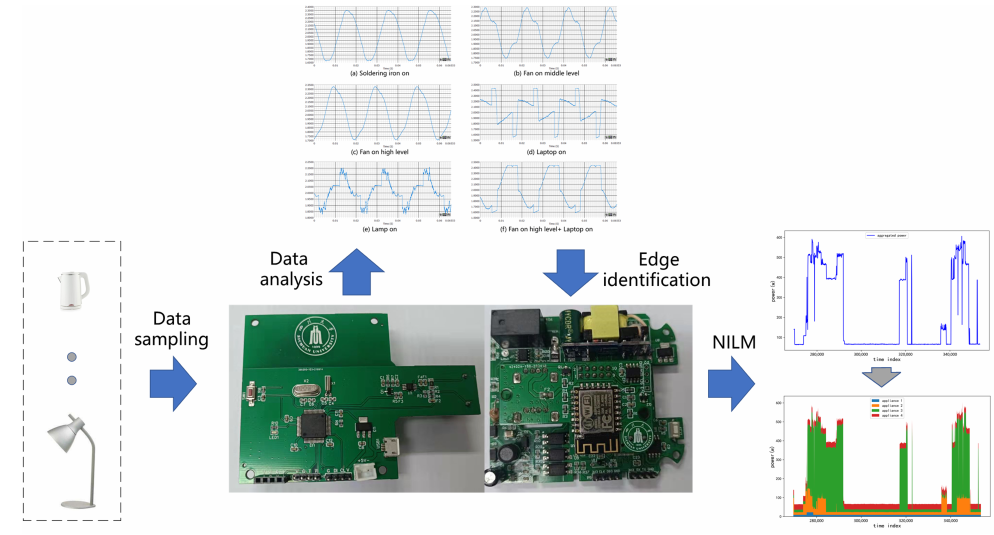
Figure 2. Diagram of appliance identification and NILM in a mixed load monitoring